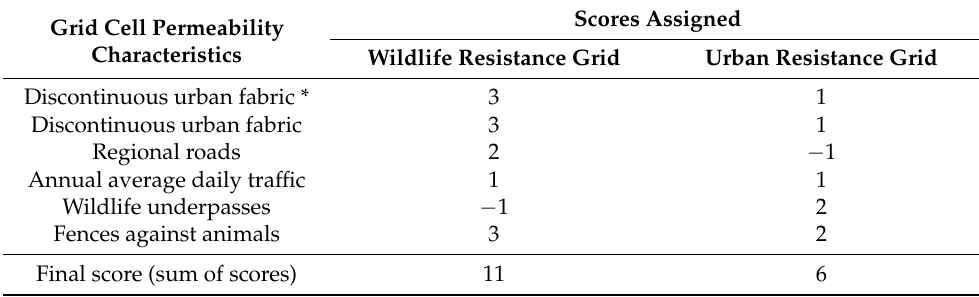
Table 4. Example of grid cell total resistance score calculation for wildlife and urban resistance grids.